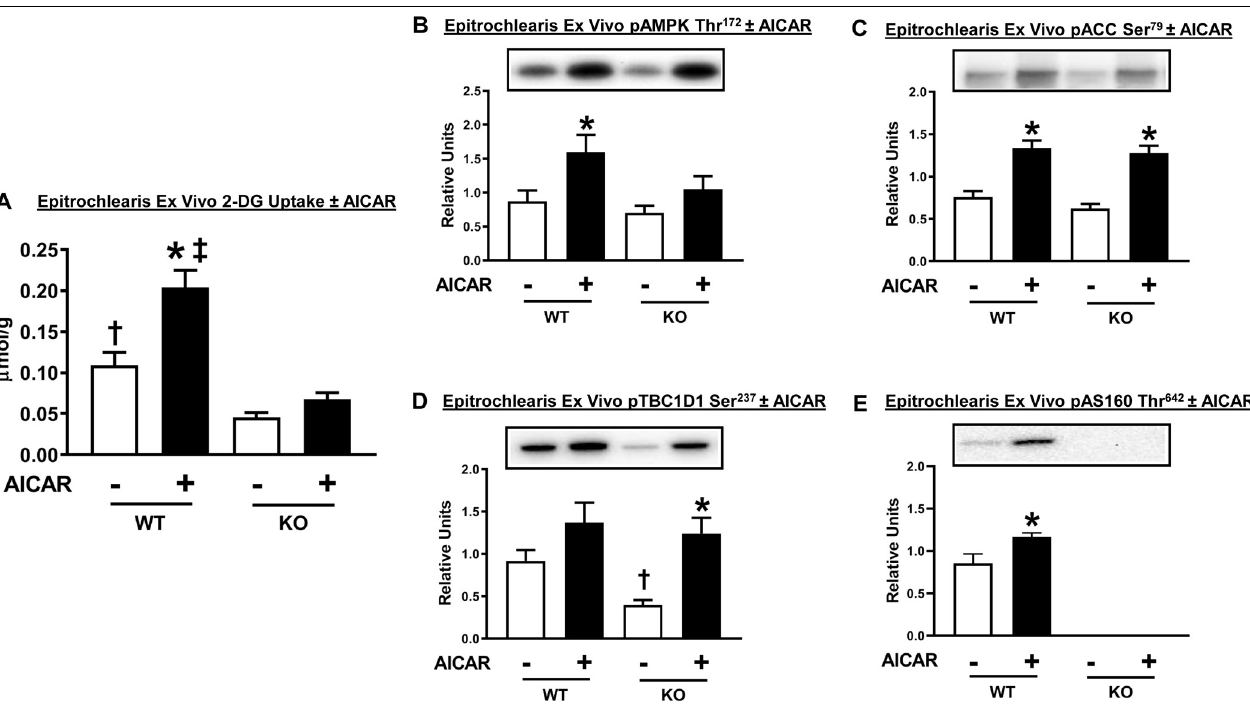
Fig 12. 2-Deoxyglucose (2-DG) uptake and the phosphorylation of AMP-activated protein kinase (pAMPK Thr 172 ), acetyl Co-A carboxylase (pACC Ser 79 ), TBC1D1 (pTBC1D1 Ser 237 ) and AS160 (pAS160 Thr 642 ) in isolated epitrochlearis from WT and KO rats. Paired muscles were incubated in the absence of (white bars) or presence of (black bars) AICAR (2 mM). Data were analyzed by two-way ANOVA, and the Holm-Sidak post hoc test except for pAS160 Thr 642 which was analyzed with a paired t-test. (A) � P < 0.001 for no AICAR versus AICAR in the same genotype; ‡ P < 0.001, WT versus KO with the same AICAR dose; † P < 0.05 for WT versus KO without AICAR. Means ± SEM for 6–9 rats of each genotype. (B) � P < 0.05 for no AICAR versus AICAR within the same genotype. A t-test revealed that pAMPK Thr 172 was significantly greater (P < 0.05) for muscles incubated with AICAR versus without AICAR in KO rats. (C) � P < 0.001, for no AICAR versus AICAR within the same genotype. (D) † P < 0.05 for WT versus KO without AICAR; � P < 0.01 for no AICAR versus AICAR in KO rats. (E) � P < 0.05, for no AICAR versus AICAR in WT rats. Means ± SEM for 6–9 rats of each genotype.